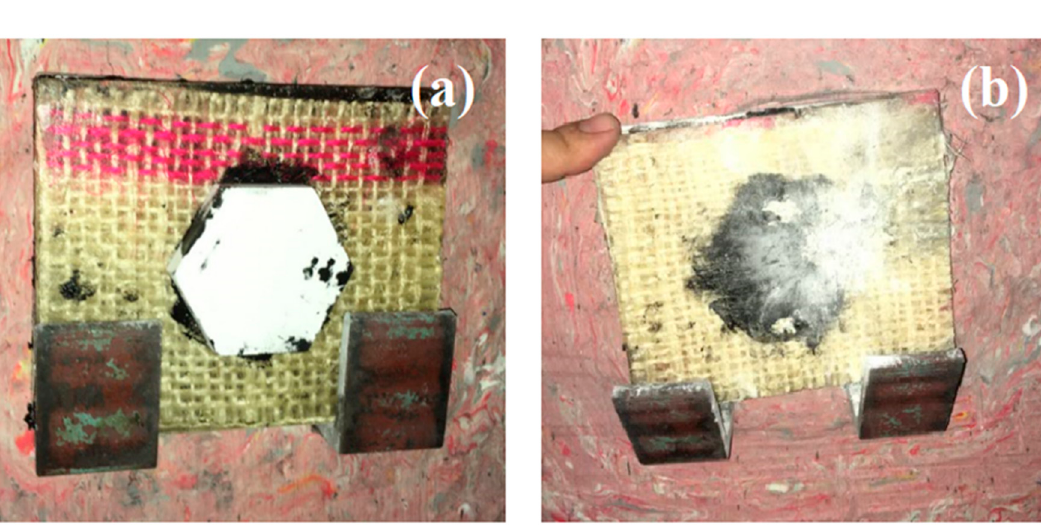
Figure 6. Typical aspect before ( a ) and after ( b ) ballistic test of MAS targets with a second layer of fique fabric-reinforced polyester composite.